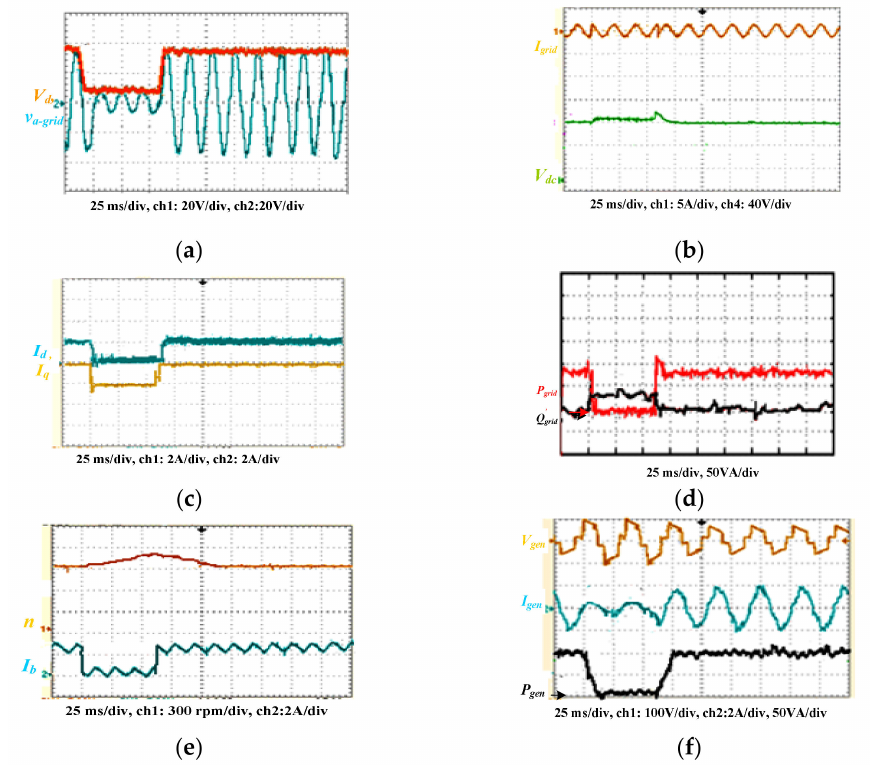
Figure 14. Experimental results during 70% symmetrical grid voltage dip using the proposed control scheme: ( a ) phase ‘a’ grid voltage v grid and d– axis grid voltage V d ; ( b ) phase ‘a’ grid current i grid and DC– link voltage V dc ; ( c ) dq– axis grid currents I d and I q ; ( d ) grid active power P grid and reactive power Q grid ; ( e ) Boost chopper current I b and PMSG speed n ; ( f ) PMSG Line-line voltage v ab − gen ,